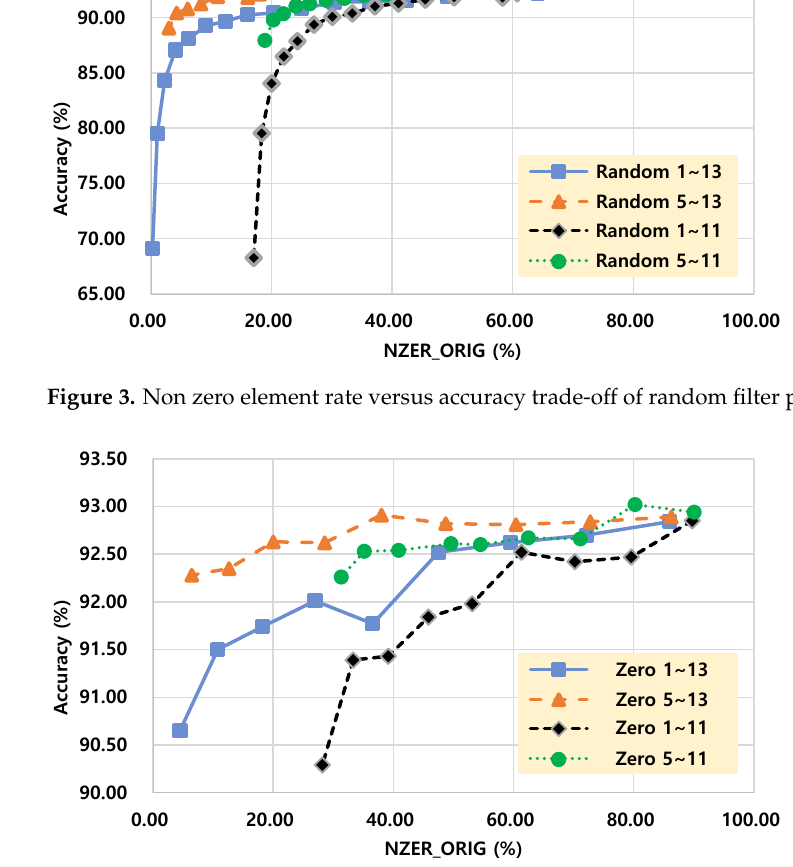
Figure 4. Non zero element rate versus accuracy trade-off of zero-keep filter pruning on VGG-16. A graph showing “accuracy versus non-zero element rate trade-off” for the two pruning methods (random filter pruning and zero-keep filter pruning) is presented in Figure 5. In the graph, the model of pruning filters on the layers from 5th to 13th using our zero-keep pruning is the most efficient at certain accuracy ranges (“ Zero 5-13 ” is evaluated as the most efficient scheme at the accuracy range from 92.9 to 92.20). Furthermore,